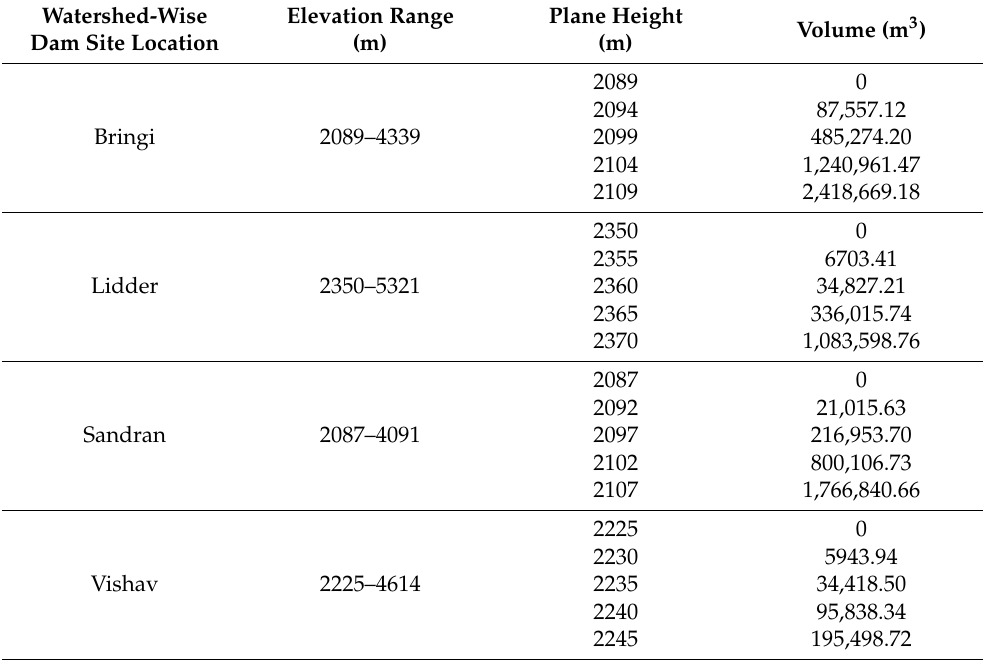
Table 4. Volume calculation at different plane heights for proposed dam sites.